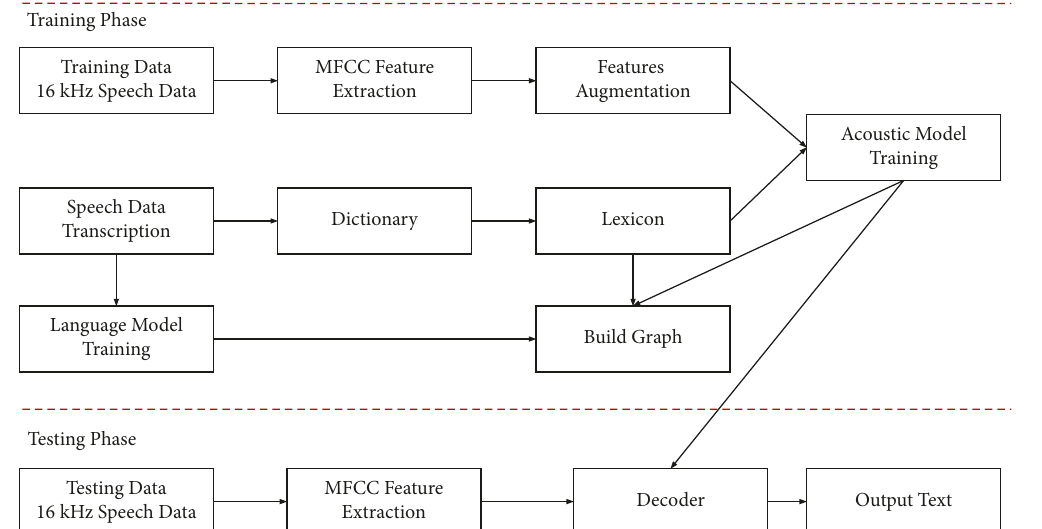
Figure 1: The illustration of creating the Indonesian speech recognition